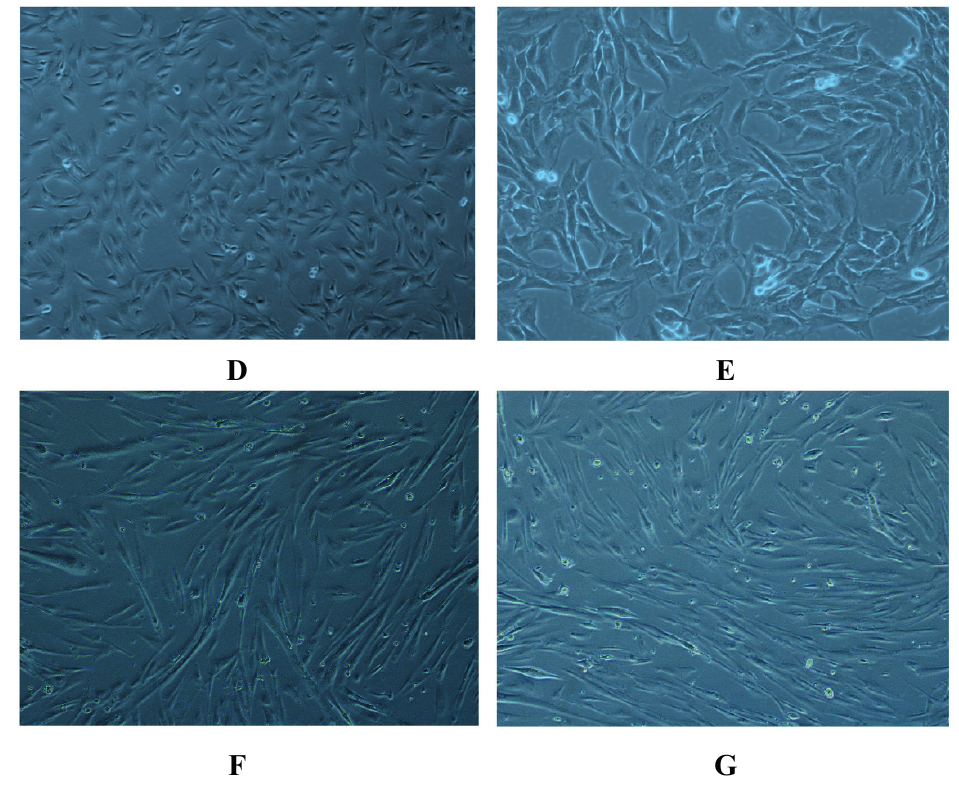
Figure 1. MTT cell viability assay on human skeletal muscle after AMA and celastrol treatment. Cell viability of AMA ( A ) and celastrol ( B ) was performed in a dose-dependent manner. The time-course evaluation of the optimal dose for AMA (30 µM) and celastrol (15 nM) was determined ( C ). Figures of the untreated cells (DMSO) ( D ), 30 µM AMA-treated cells ( E ), 15 nM celastrol-treated cell ( F ) and AMA-treated cells